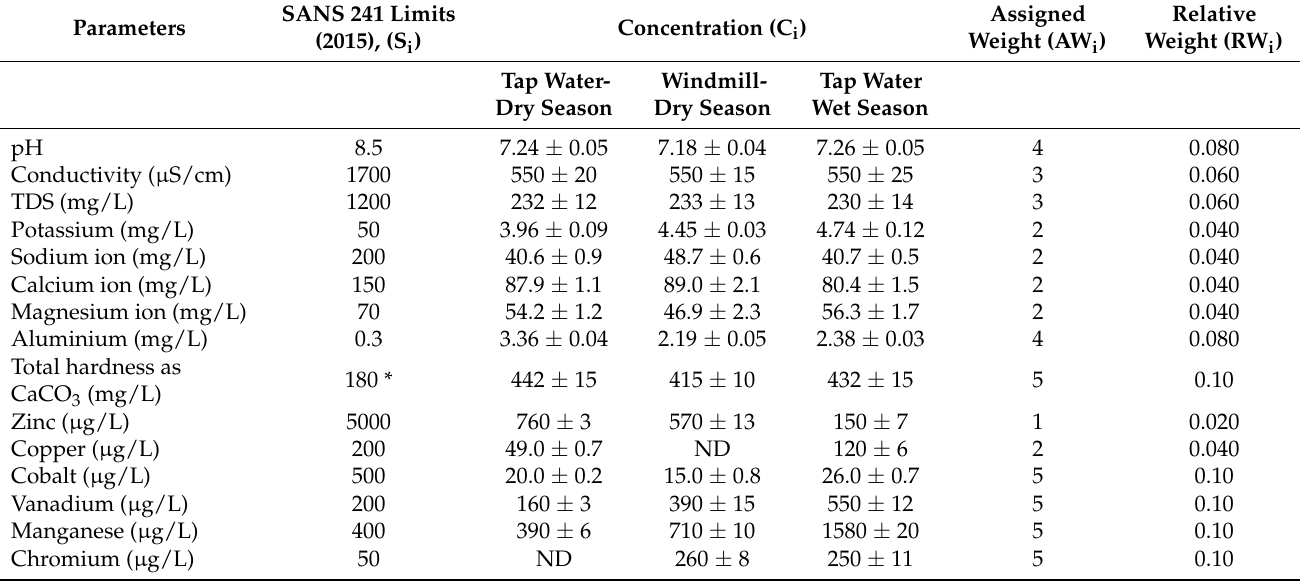
Table 4. WQI parameters, WHO desirable limit (2011 weights and relative weights) [34 – 38].